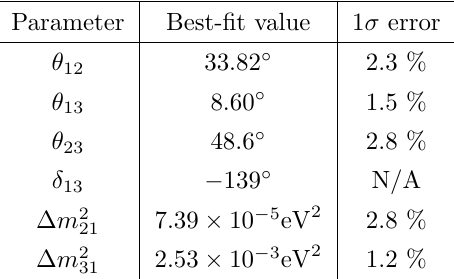
Table 2 . Best-(cid:12)t values of the neutrino oscillation parameters for the standard three-(cid:13)avor scenario adopted from ref. [1].